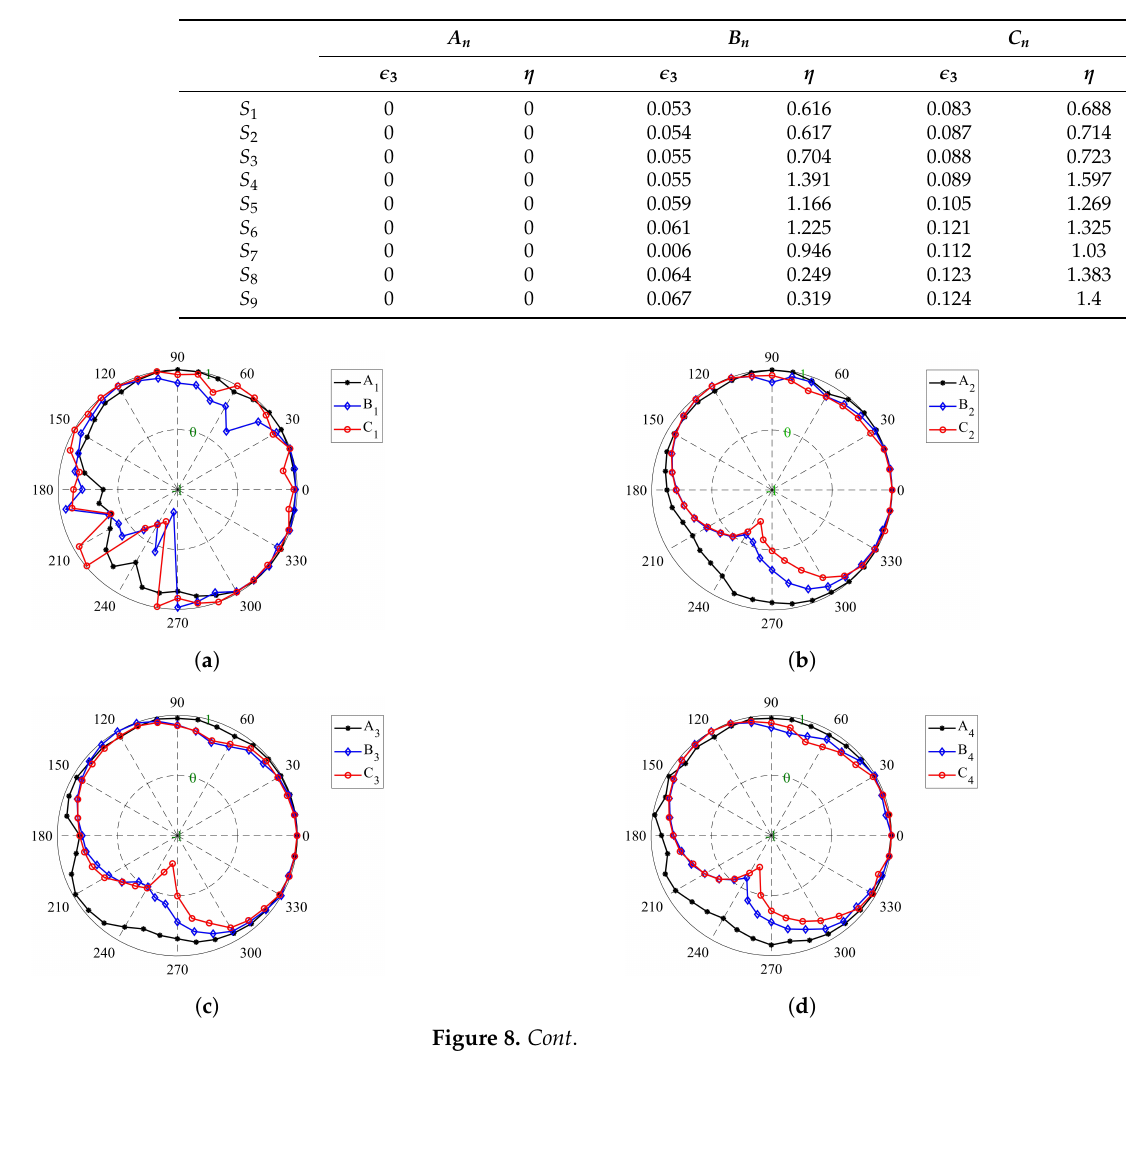
Table 4. Deviatoric stress ratio η and axial strain (cid:101) 3 corresponding to the critical points of specimens S n ( n = 1,2, · · · ,9).